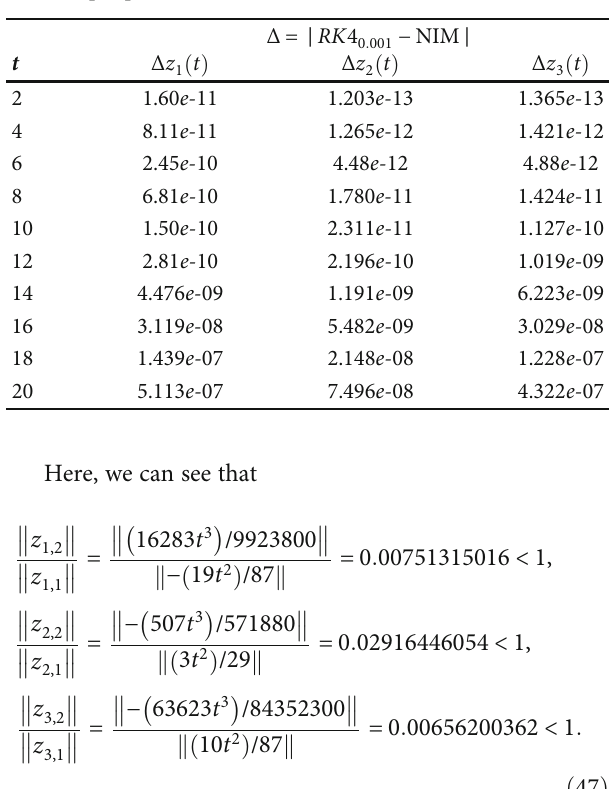
Table 4: Di ff erences between 9-iteration NIM with RK4 solutions in the step input